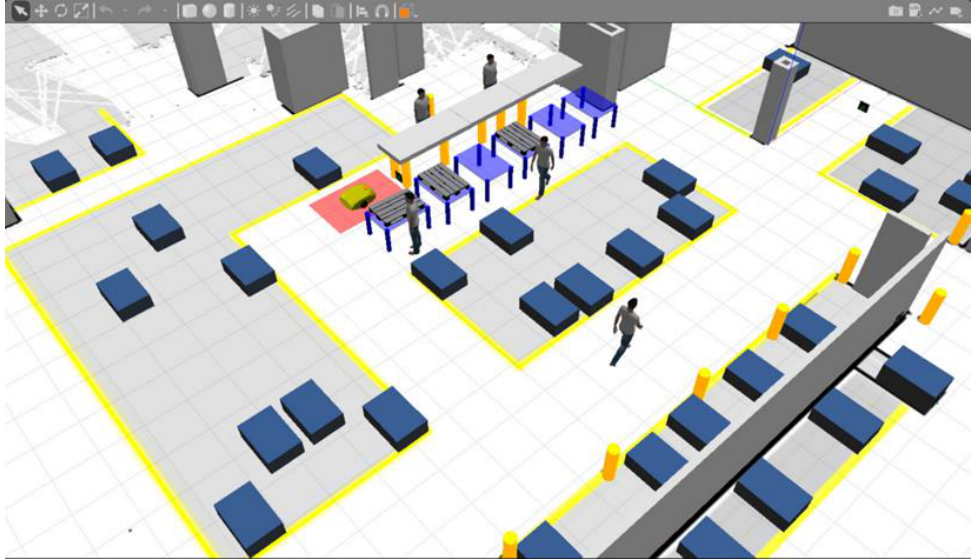
Figure 5. View of the digital twin of the real factory hall (model created in Gazebo simulator).